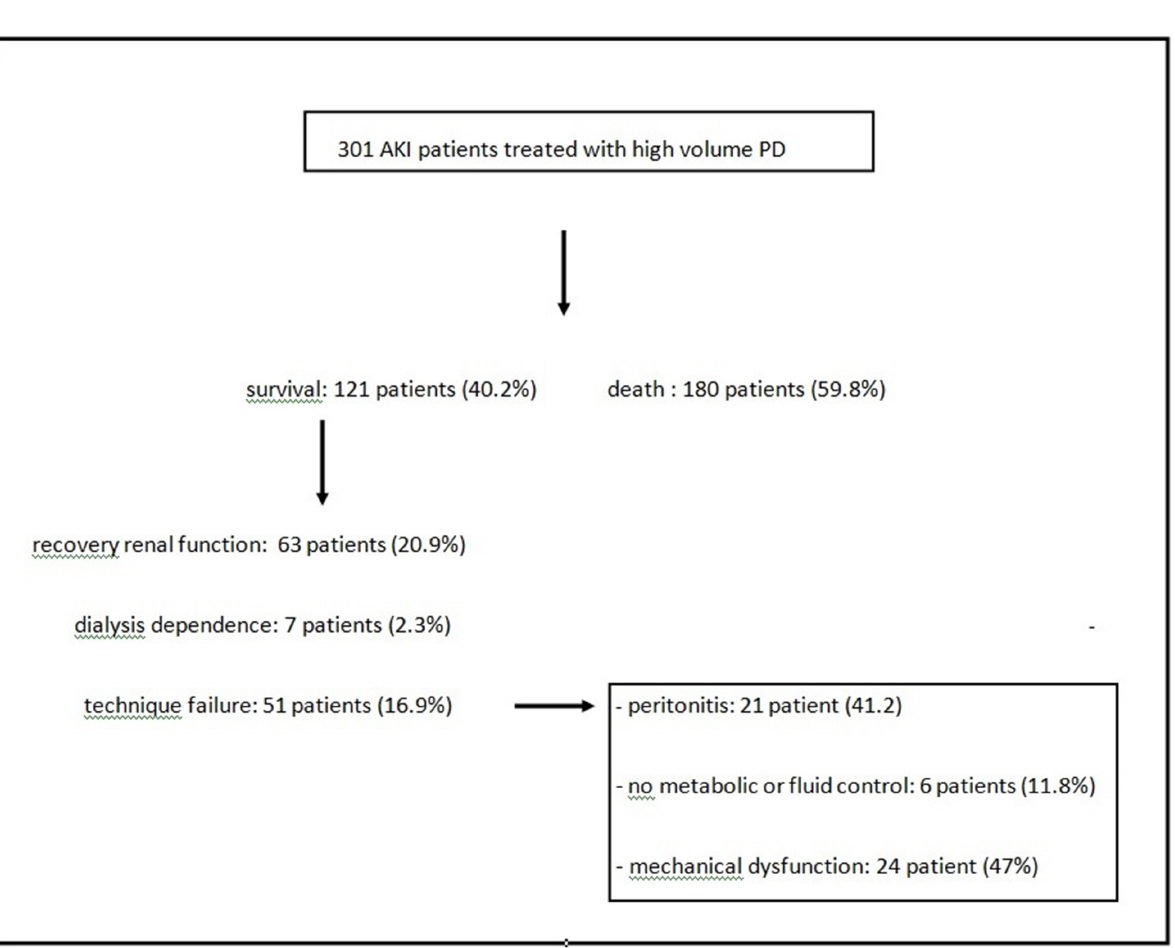
Fig 1. Acute kidney injury (AKI) patient outcome treated with high volume peritoneal dialysis.